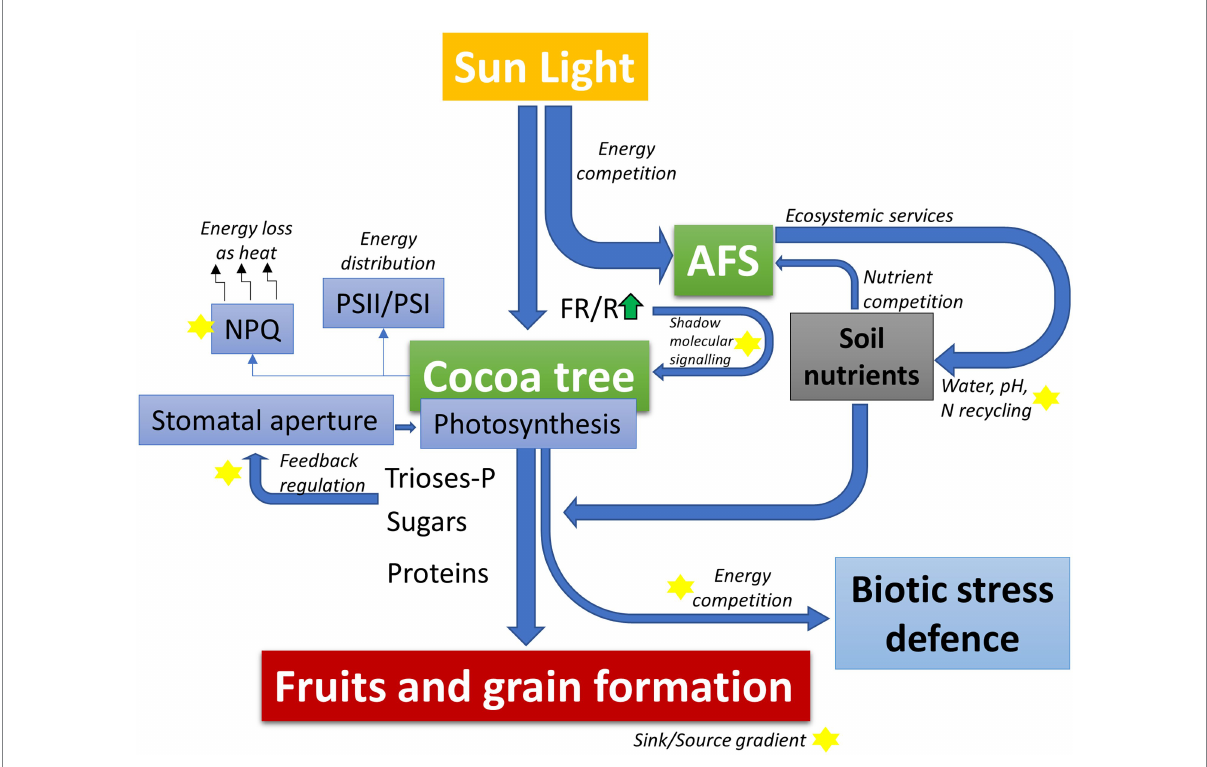
FIGURE 1 Schematic model highlighting the balance of light energy, carbon skeletons, and nutrients use distributed between activation of protection mechanisms against biotic stresses and productivity within the context of an agroforestry systems (AFS). In AFS, cocoa competes for light energy and soil nutrients with the shading tree species. This competition is directly counterbalanced by the ecosystem services provided by the shading trees that can favor water use efficiency and chemical soil properties (better availability of nutrients). Furthermore, differences in light quality (red/ far-red light composition – FR/R) and contrasting balance in the levels of trioses-phosphate and other signaling molecules may activate physiological compensation pathways to optimize the energy balance of cocoa plants depending on the genetic background. These physiological compensatory responses may include adjustments in stomatal regulation, induction/relaxation of excess energy dissipation mechanisms (non- photochemical quenching, NPQ), and stoichiometric adjustments in the photosystem complexes (PSII/PSI). Finally, the resulting dynamic energetic and metabolic balance of the AFS-cacao model may directly compete with the energetic/metabolic demand of biotic stress defense mechanisms, thus determining the degree of limitation on the potential productivity of each genotype specifically. Yellow stars in the figure represent central processes for deeper investigation in AFS-cocoa